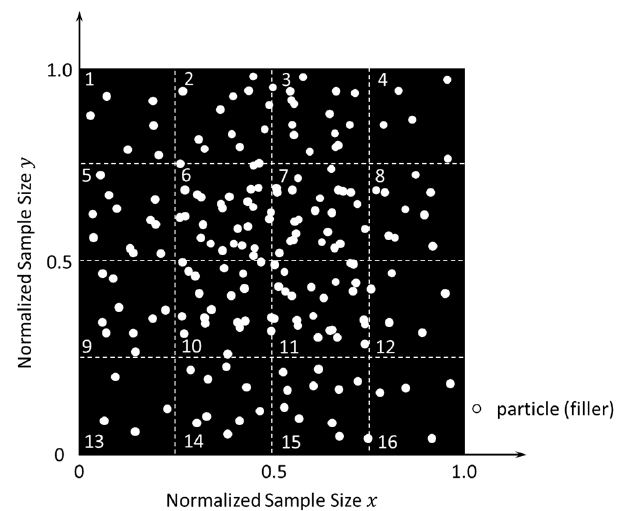
Figure 4. The concept of the simplified discrepancy calculation. This figure shows an example of n =